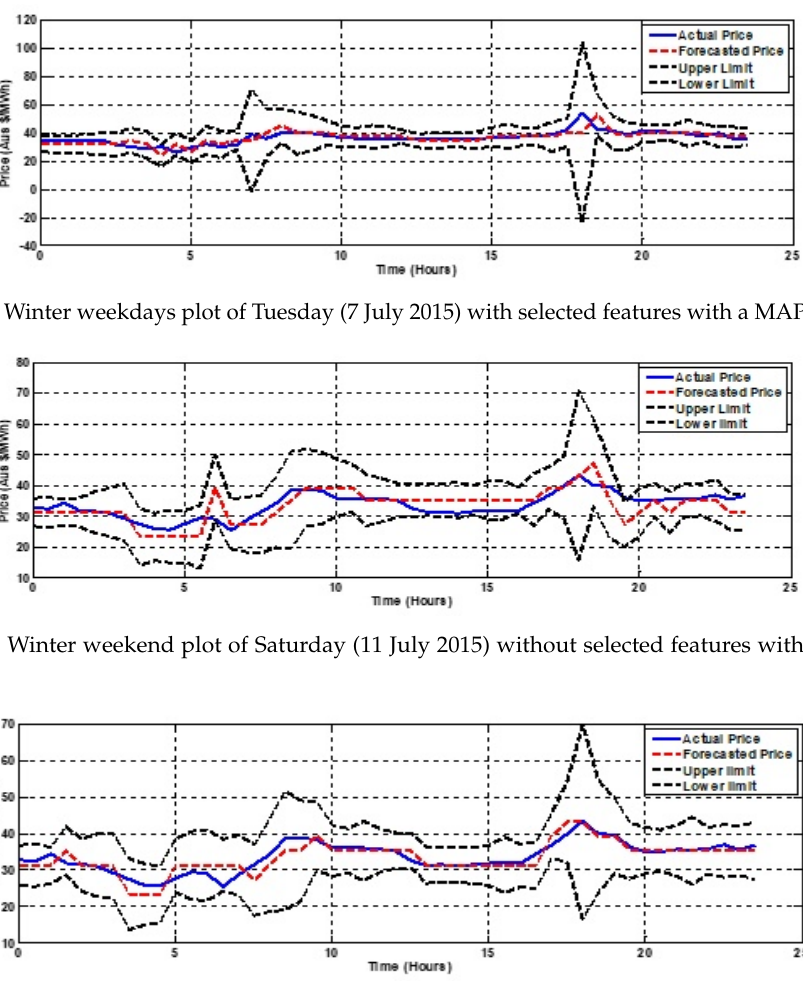
Figure 18. Winter weekends plot of Saturday (11 July 2015) with selected features with a MAPE of 4.98.